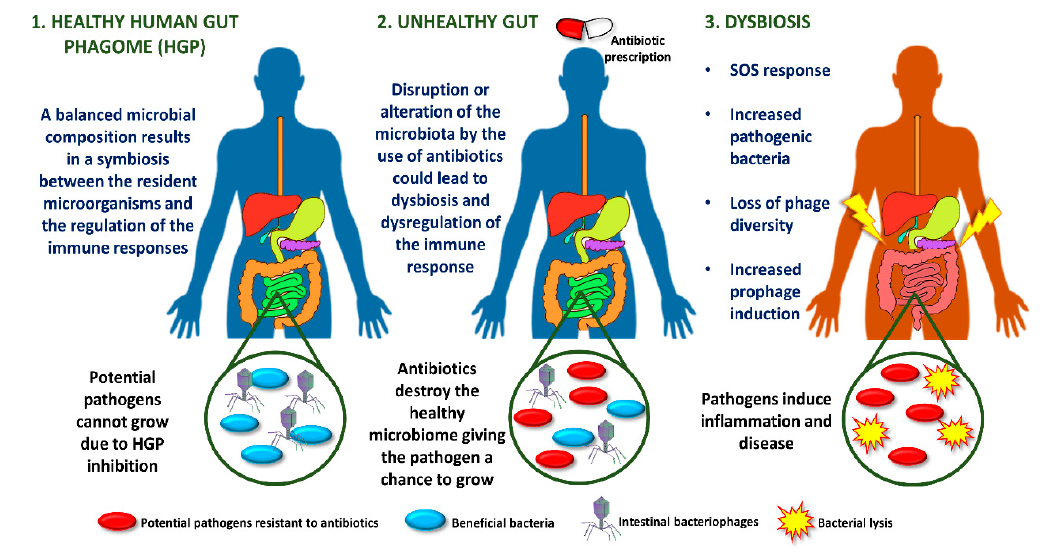
Figure 1. Antibiotic-associated intestinal dysbiosis.